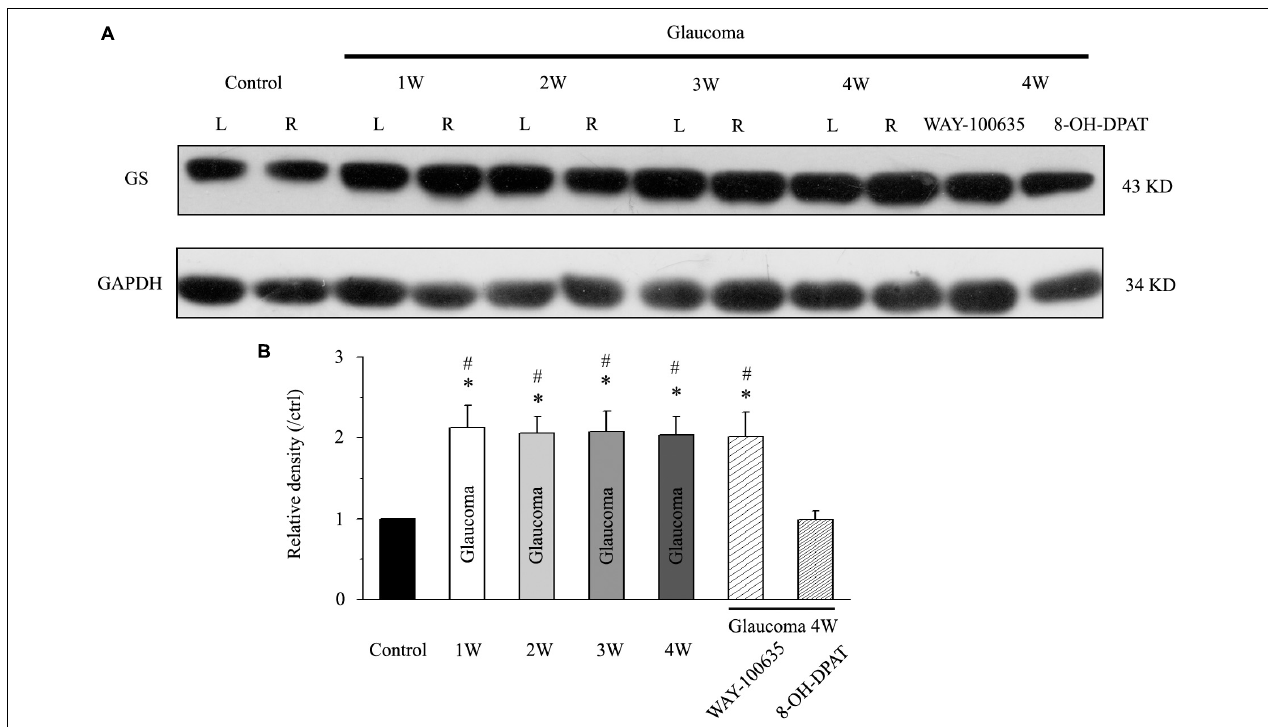
FIGURE 1 | Chronic ocular hypertension and WAY-100635 upregulated GS expression in the rat retina, but this effect was reversed by 8-OH-DPAT. (A) Representative western blot of GS expression in control and glaucomatous retinas at 1, 2, 3, and 4 weeks after EVC and in glaucoma 4W + WAY-100635 retinas and glaucoma 4W + 8-OH-DPAT retinas. The expression of the 43 kDa protein was decreased from 1 week to up to 4 weeks after EVC. WAY-100635 upregulated GS expression and 8-OH-DPAT downregulated GS expression 4 weeks after glaucoma induction. (B) Densitometric analysis of GS expression from 1 to 4 weeks ( n = 6) after EVC. GS expression was normalized to the expression in the control retinas. ANOVA, ∗ p < 0.05 vs. control retina, # p < 0.05 vs. glaucoma 4W + 8-OH-DPAT. W, week; GS, glutamate synthetase; L, the left eye; R, the right